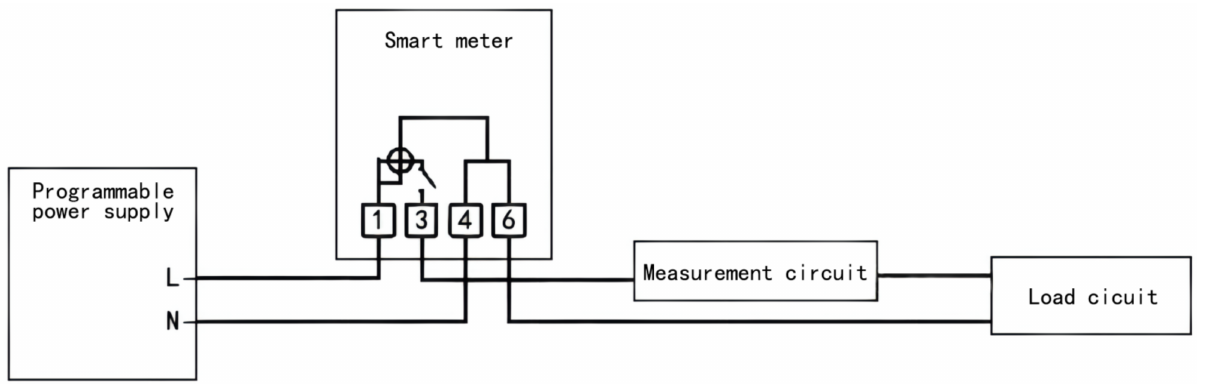
Figure 4. Block diagram of the test system.